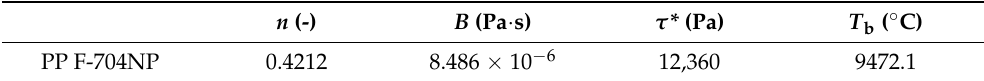
Residence Time Meas.